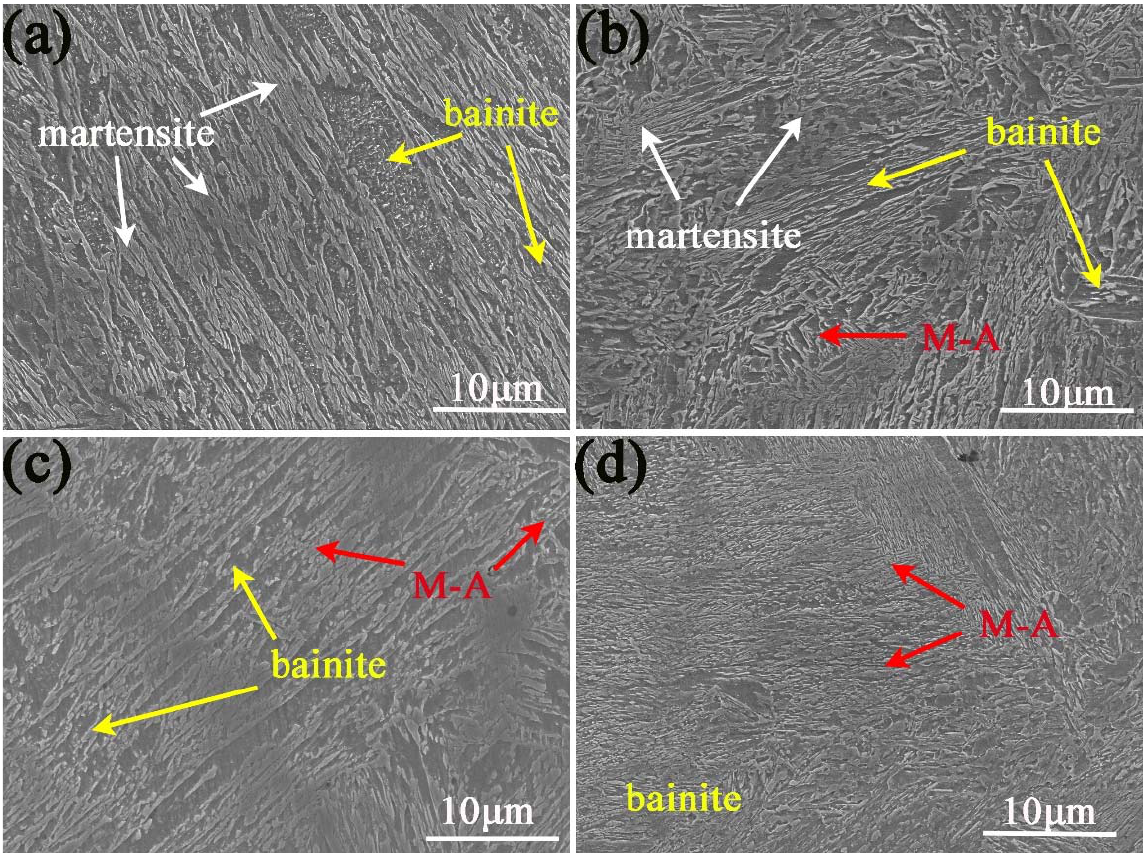
Figure 2. Multiphase microstructure of deposited metals with different Cu addition. ( a ) Cu 0.62, ( b ) Cu 1.38, ( c ) Cu 1.79, ( d ) Cu 2.32.